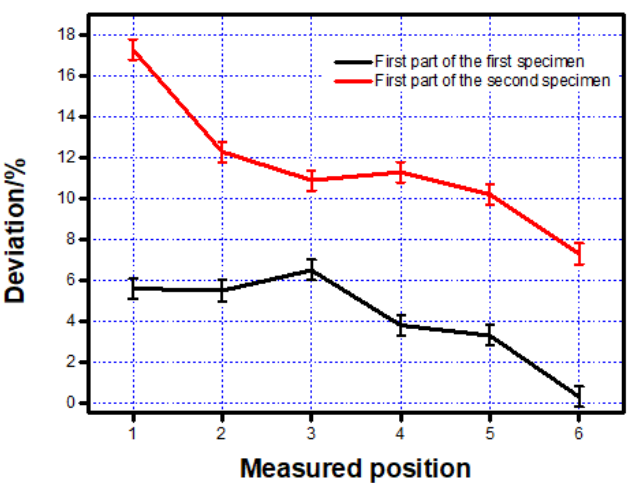
Figure 5. Deviation between the measured and designed data of the two specimens on the first part.